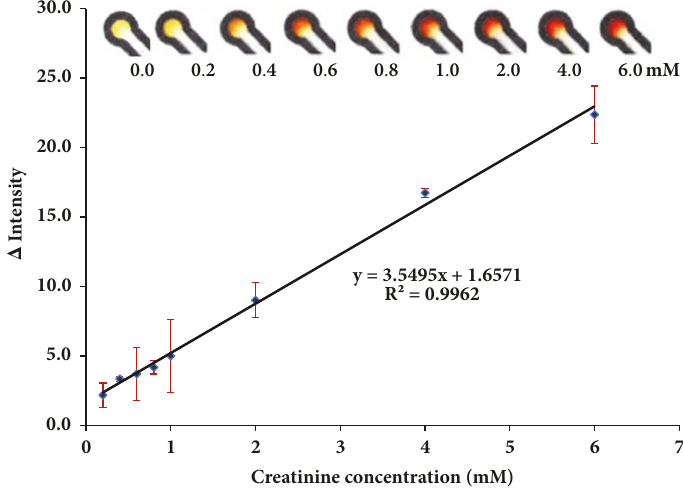
Figure 7: Calibration plots for the creatinine determination (n=3).